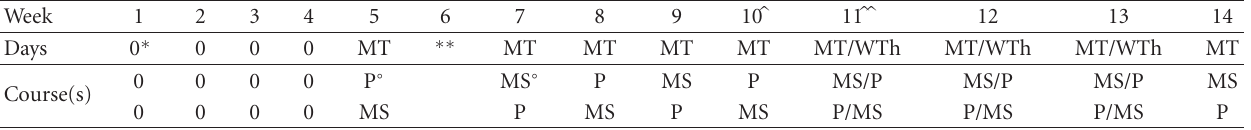
Table 2: Students clinical immersion